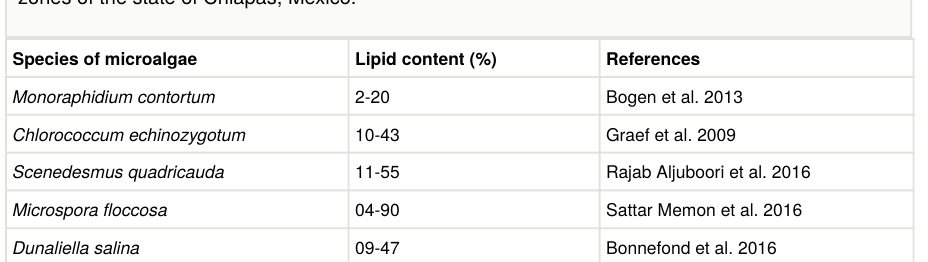
Lipid content of fi ve microalgae with potential for biodiesel production identi fi ed in the hydrographic zones of the state of